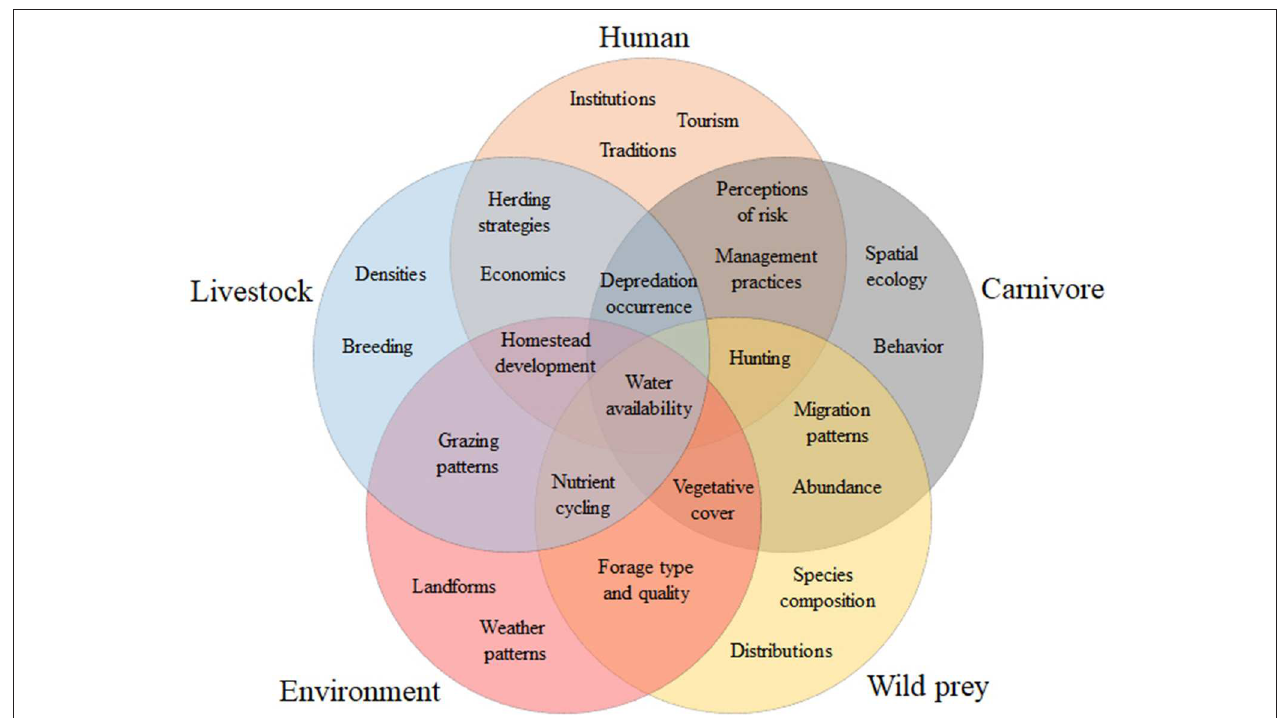
FIGURE 1 | A model for human-lion ( Panthera leo ) conflict composed of five distinct and overlapping dimensions. A non-exhaustive list of factors within and between dimensions is